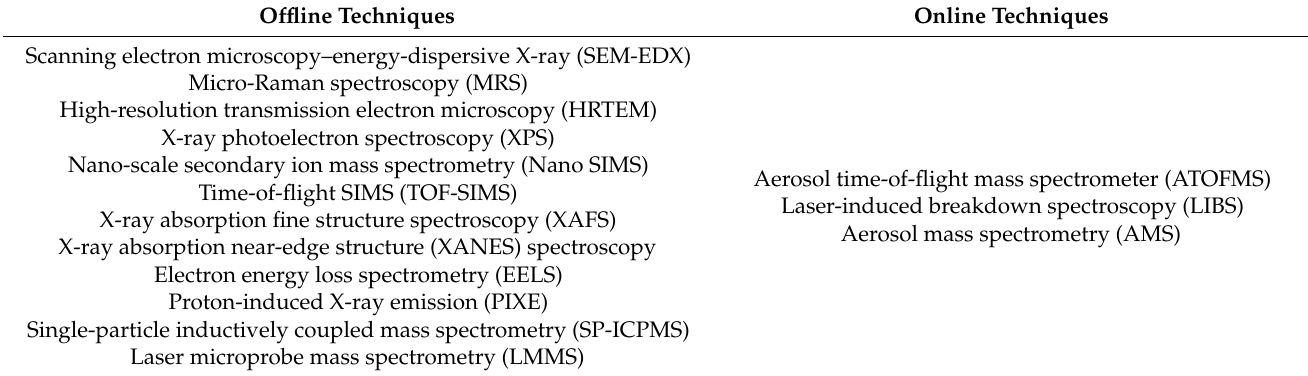
Table 1. Some offline and online techniques used for the single-particle-level characterization of